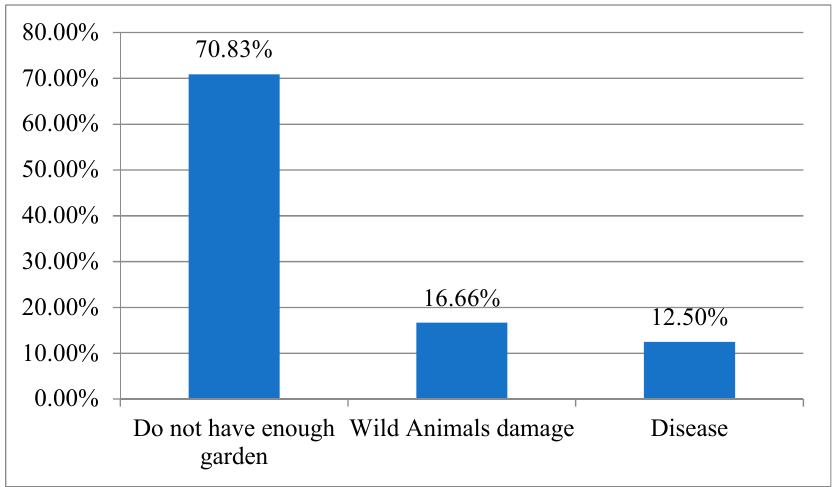
Figure 4. Given reasons for not growing any fruit in the home garden.